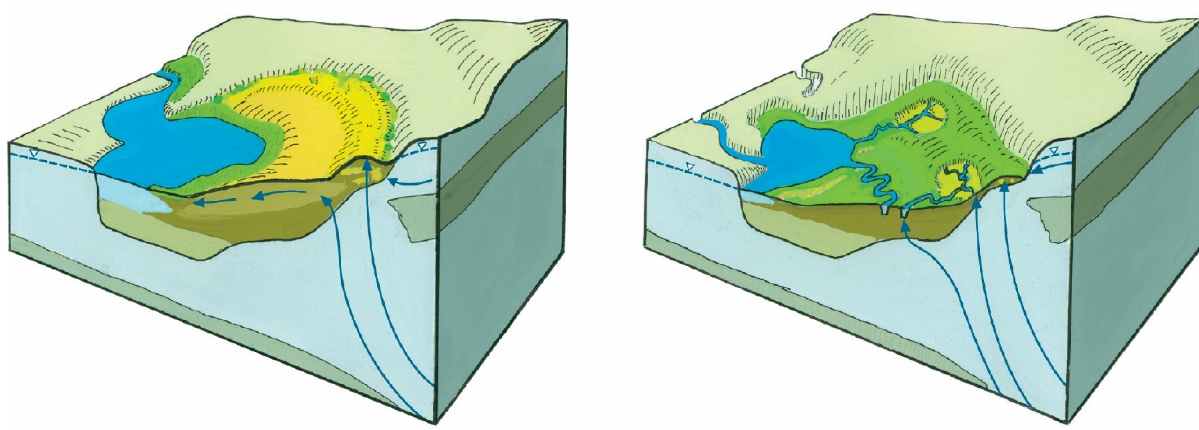
Figure 8 . Conceptual model of mire development before (left) and after (right) lowering lake water levels in Eastern Europe. Arrowed lines are inferred flows of groundwater. In the lowlands of Eastern Europe lake levels were already lowered in mediaeval times, in some cases by several metres (Grootjans et al . 2006b). The steeper hydrological gradient caused erosion in the cupola-shaped spring fens (yellow) that had developed next to the lakes (blue). The eroding spring rivulets caused peat degradation (brown) and establishment of eutrophic alder forest (green).